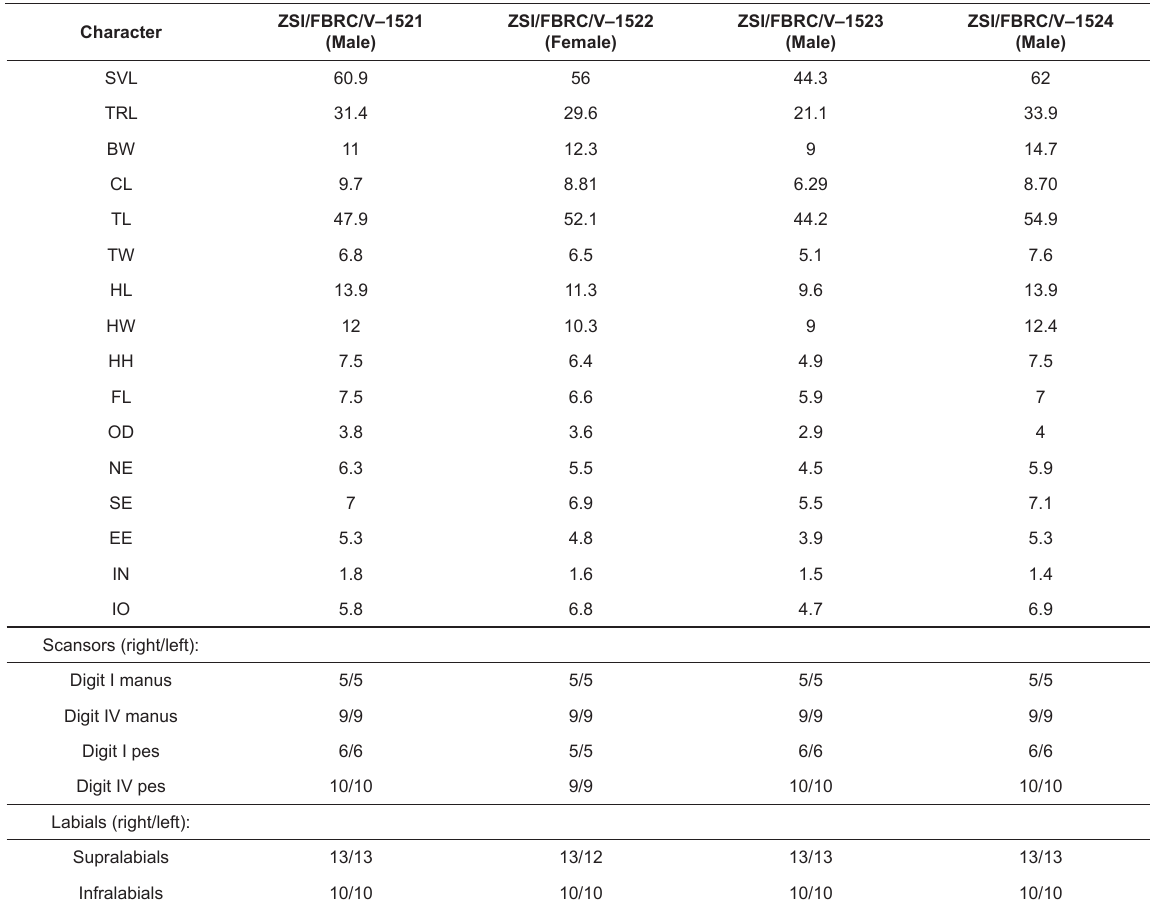
Table 1. Morphometric and meristic data on Hemidactylus cf. frenatus from Tyda, Ananthagiri and Araku in Ananthagiri Hills, northern Eastern Ghats, Andhra Pradesh (all morphometric measurements in